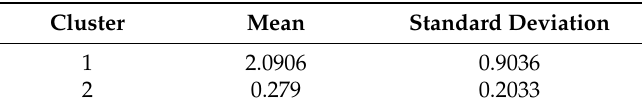
Table 4. EM clustering